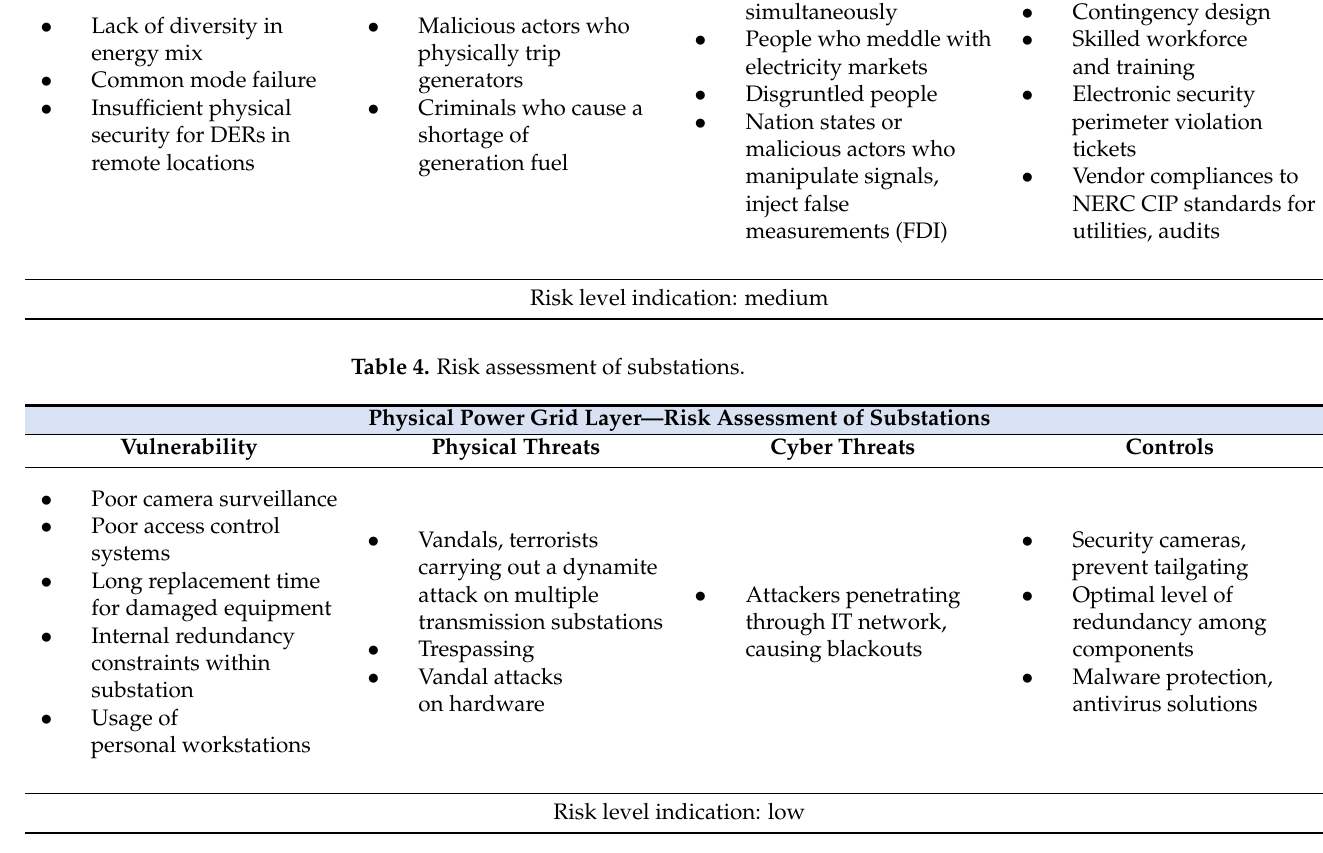
Table 5. Risk assessment of electric power